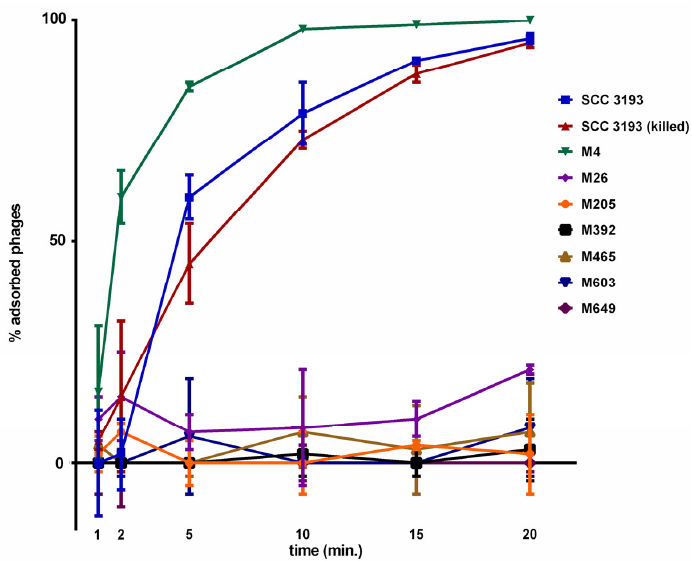
Figure 1. Adsorption of ϕ A38 to viable WT P. parmentieri, WT killed with chloramphenicol, and seven phage ‐ resistant mutants. A MOI of 0.01 of ϕ A38 was used for adsorption assay and the total assay time was 20 min. Phage adsorption was calculated as follows: the percentage adsorption = (the average titer of unabsorbed phages per sample/average titer of phages in negative control) × 100. The averages together with standard deviations of three independent repetitions per strain (WT or mutants) are shown.